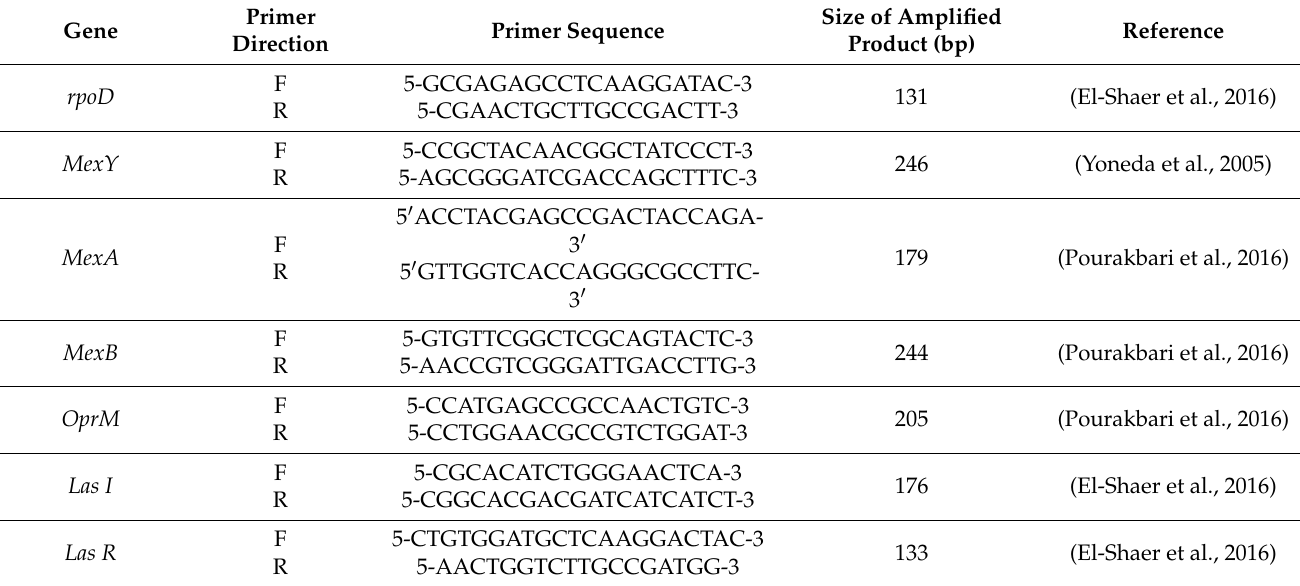
Table 8. The sequence of the primers used in this